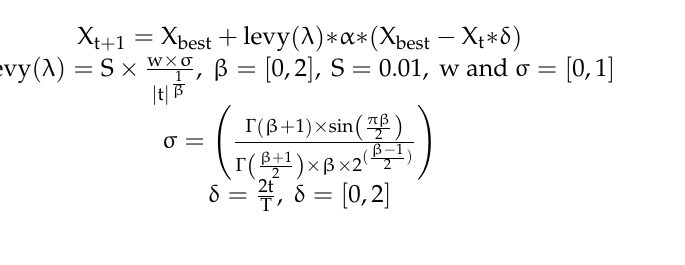
Finally, in the last stage, the dandelion seeds choose their random position in the landing stage. With more iterations, it is hoped to reach the global optimal solution. At this stage, the global optimal solution can be achieved by sharing X best information through search agents to local neighborhoods. Therefore, we will have Equation